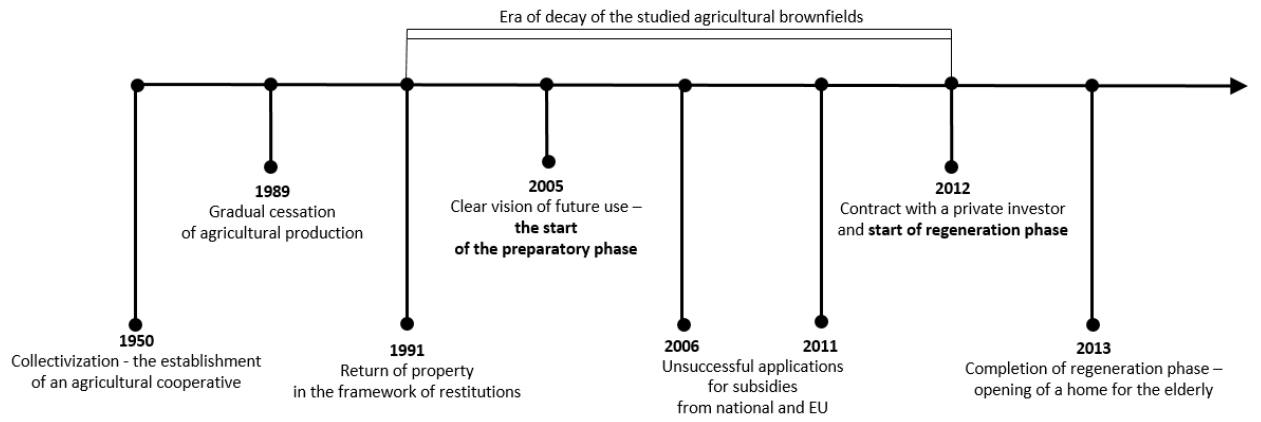
Figure 3. Timeline of the key milestones of the development of the regeneration project in Vranovice. Source: Authors’ own processing.